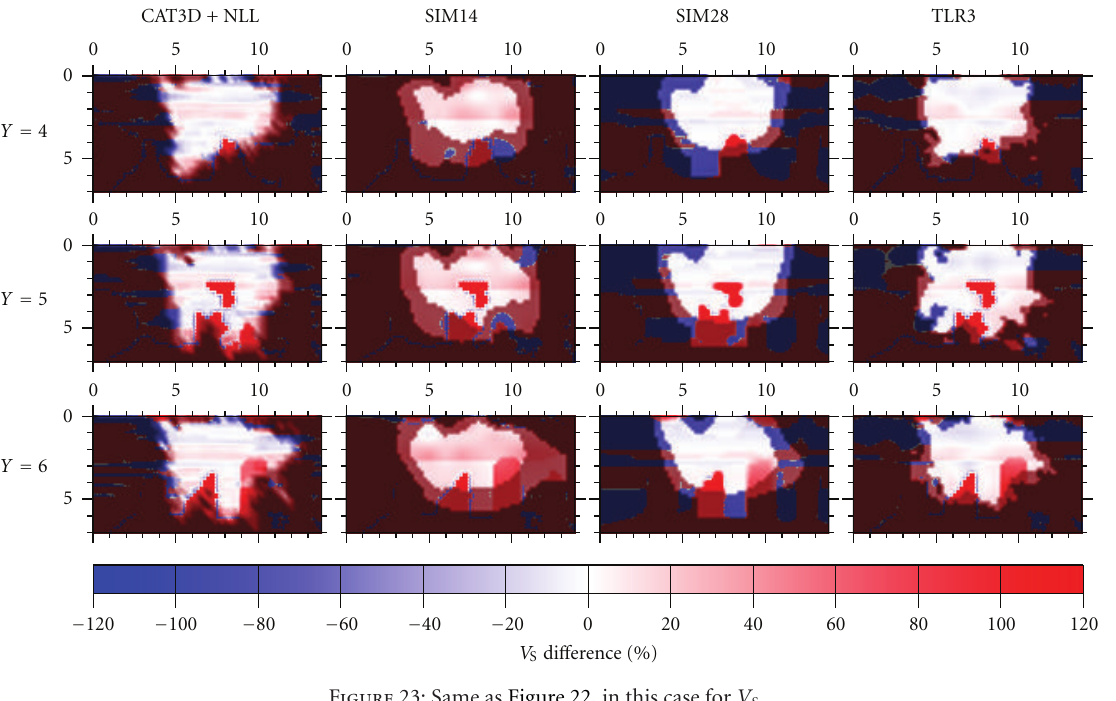
Figure 23: Same as Figure 22, in this case for V S .